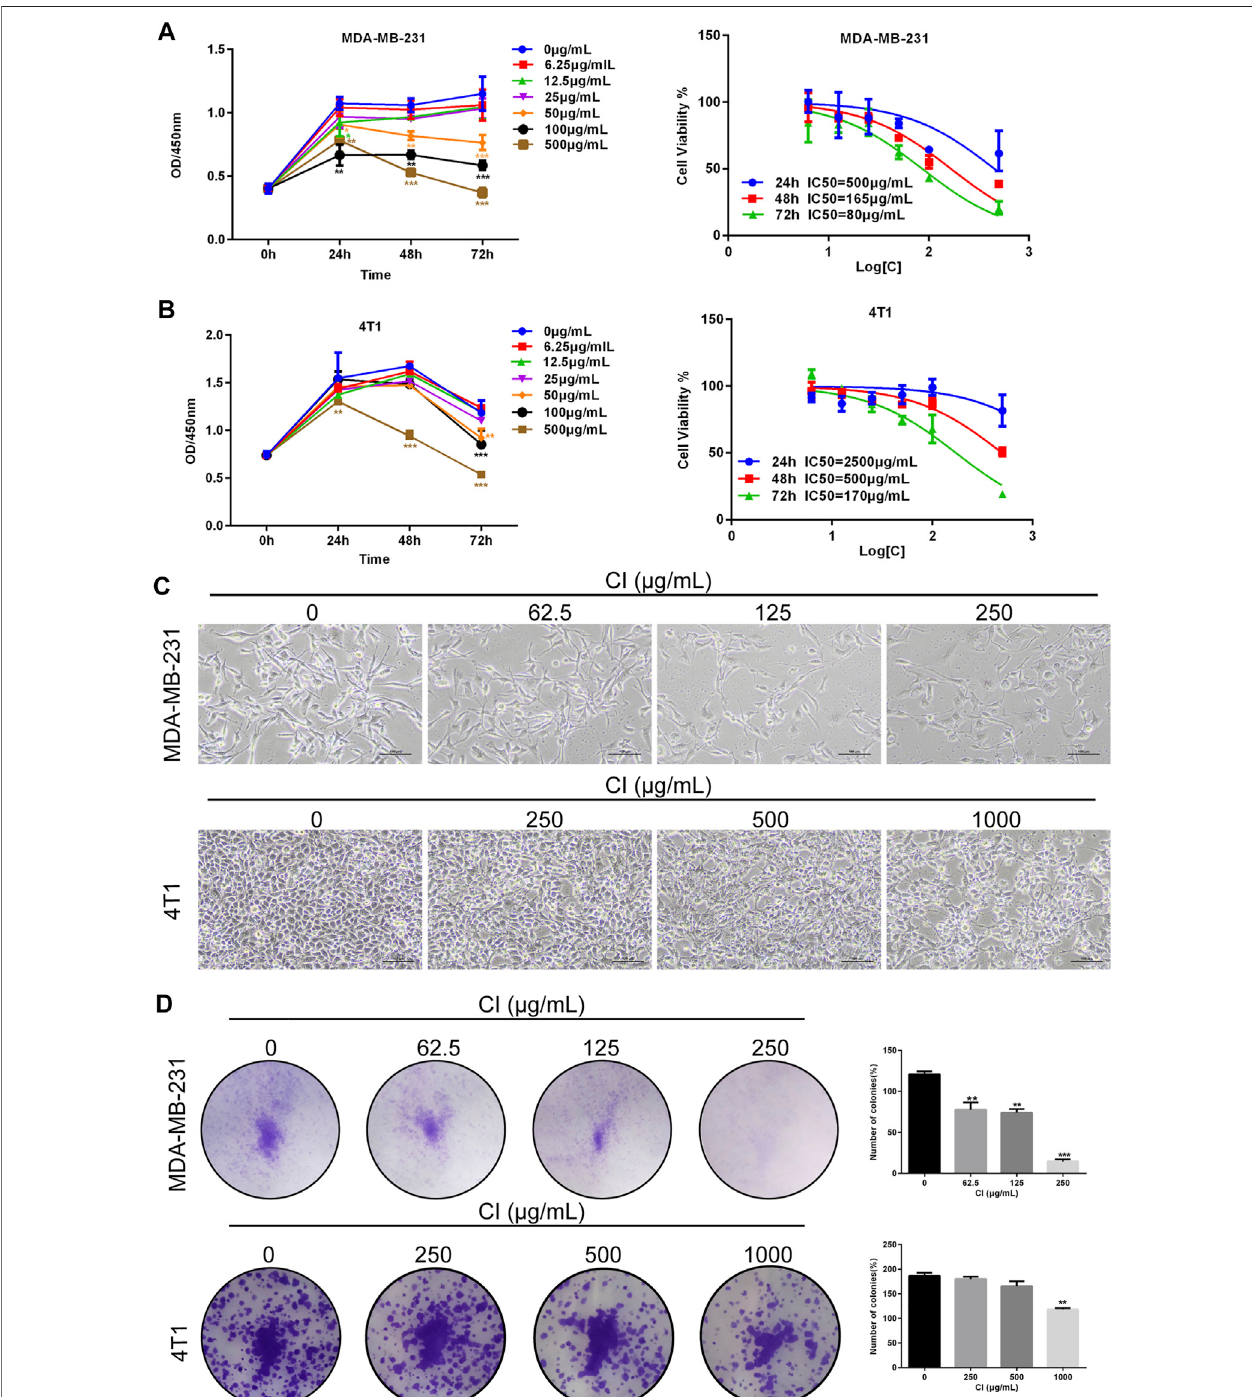
FIGURE 1| CI reduces cell viability of TNBC cells. (A) MDA-MB-231 cells was treated with CI (0, 6.25, 12.5, 25, 50, 100, and 500 μ g/ml) for 24, 48, and 72 h, and cell viability was determined by the CCK8 assay. (B) 4T1 cells was treated with CI (0, 6.25, 12.5, 25, 50, 100, and 500 μ g/ml) for 24, 48, and 72 h, and cell viability was determinedbytheCCK8assay. (C) MorphologicalchangesofMDA-MB-231and4T1cellstreatedwithCI(0,62.5,125,and250 μ g/mlor0,250,500,and1000 μ g/ml). (D) Colony formation assay of MDA-MB-231 and 4T1 cells exposed to CI (0, 62.5, 125, and 250 μ g/ml or 0, 250, 500, and 1000 μ g/ml) for 14 days. The colony numbers ( > 50 cells/colony) are calculated manually. * p < 0.05, ** p < 0.01, *** p < 0.001, and **** p < 0.0001 vs. control.